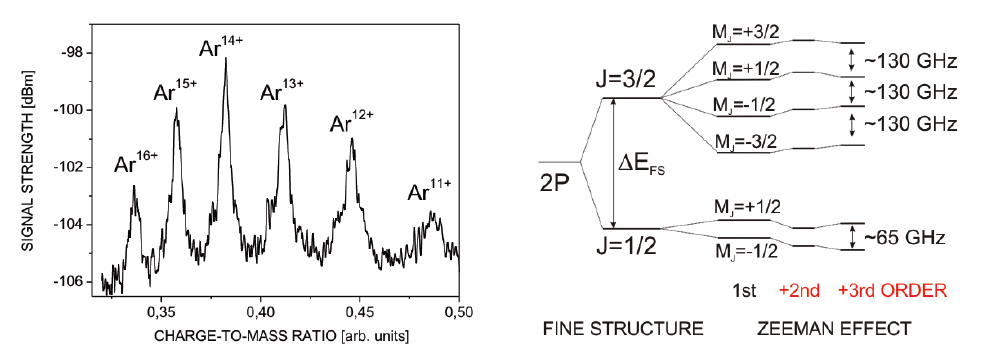
Figure 8. Charge state spectrum of in-trap created argon ions ( left ) and fine structure level scheme with Zeeman substructure of boron-like argon ( right ) with energy level shifts by second and third order contributions indicated (not to